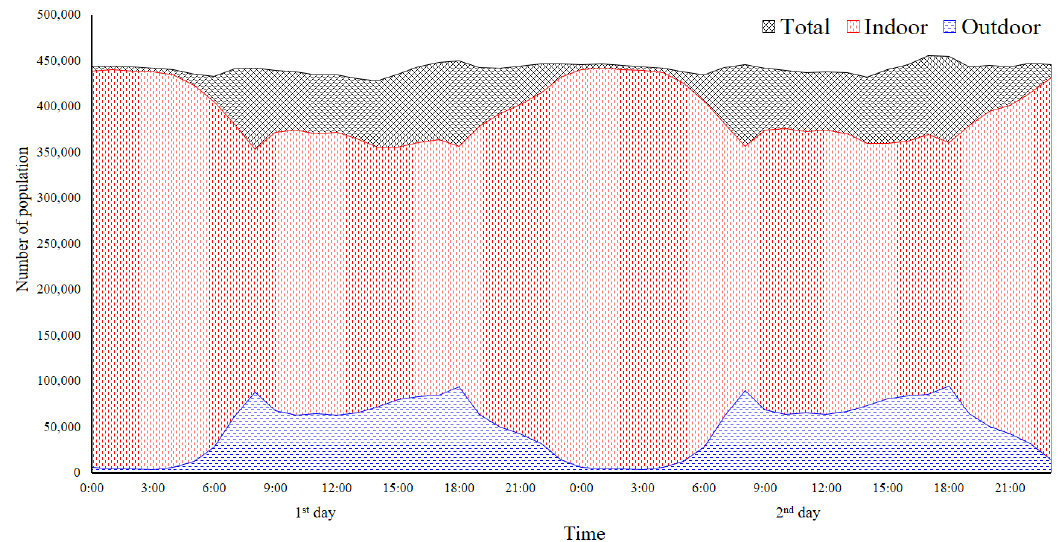
Figure 6. Correlation between outdoor PM 2.5 concentrations measured by the Urban Air Monitoring Station and modeled by sensor-based air monitoring instruments in Guro-gu.